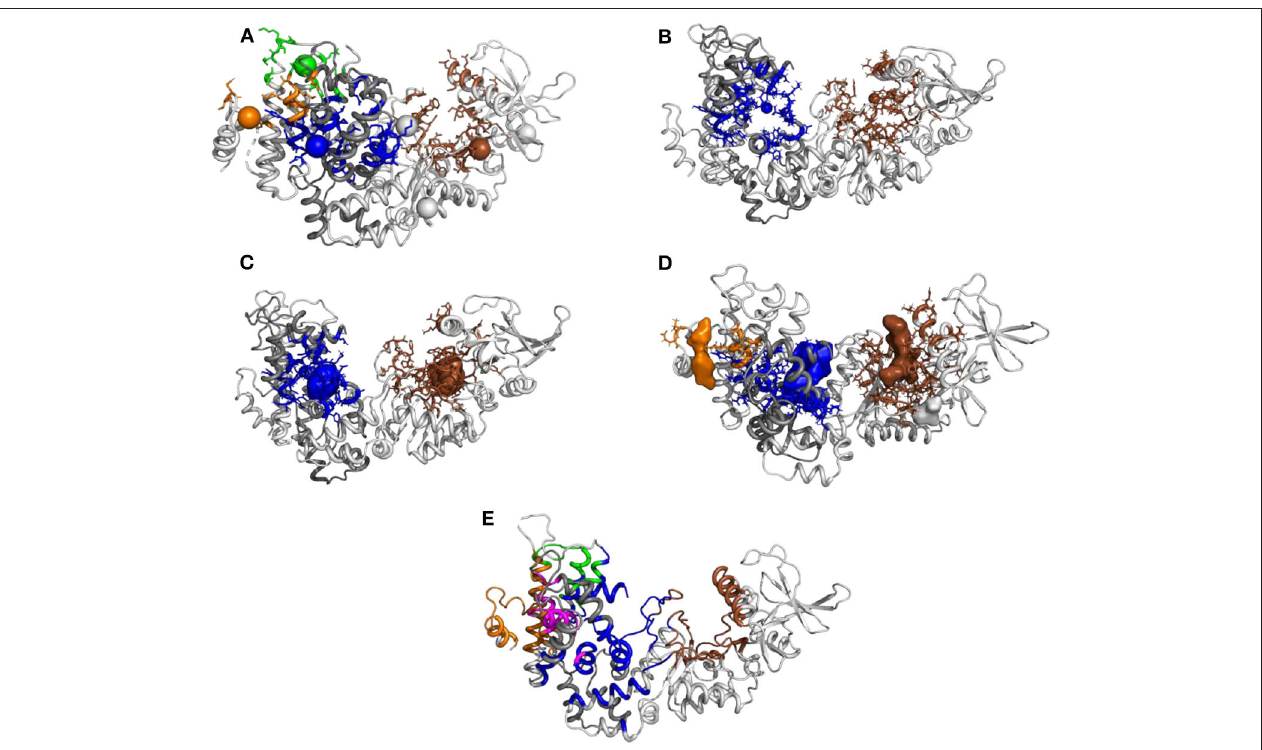
FIGURE 9 | Prediction of pockets druggability or allostery on the initial EF/CaM structure 1PK0 using several methods: (A) PARS (bioinf.uab.cat/cgi-bin/pars-cgi/ pars.pl), prediction of the druggable pockets, three of them correspond to mkgridXf cavities: 64 (blue), 130 (orange), and 140 (brown). (B) Deepsite (www. playmolecule.com/deepsite), prediction of two druggable pockets, displaying scores of 0.999 and corresponding to mkgridXf cavities: 64 (blue) and 140 (brown). (C) FTMap (ftsite.bu.edu), prediction of two druggable pockets, corresponding to mkgridXf cavities: 64 (blue) and 140 (brown). (D) POCASA (altair.sci.hokudai.ac.jp/g6/ Research/POCASA_e.html), prediction of five druggable pockets, two of them corresponding to the mkgridXf cavity 140 (brown), and two others to the mkgridXf cavities: 64 (blue) and 130 (orange). (E) CavityPlus (www.pkumdl.cn:8000/cavityplus/index.php), prediction of the allosteric pockets influenced by the orthosteric pocket located in the catalytic site (brown). Four allosteric pockets are predicted with the corresponding scores: Cavity1 (3.36), Cavity5 (1.50), Cavity10 (0.75), Cavity4 (0.70). These cavities correspond to the mkgridXf cavities: 64 (blue), 130 (orange/magenta), 83